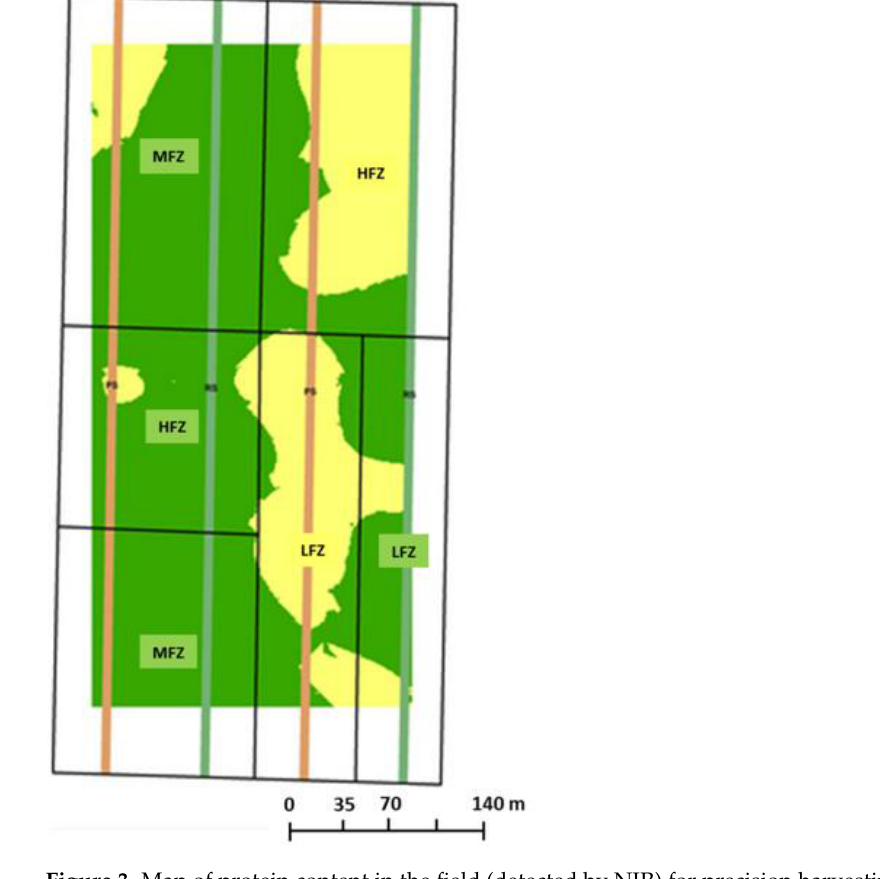
Figure 3. Map of protein content in the field (detected by NIR) for precision harvesting (green areas >13%; yellow areas ≤ 13%). HFW = high fertility zone; MFW = medium fertility zone; LMW = low fertility zone.